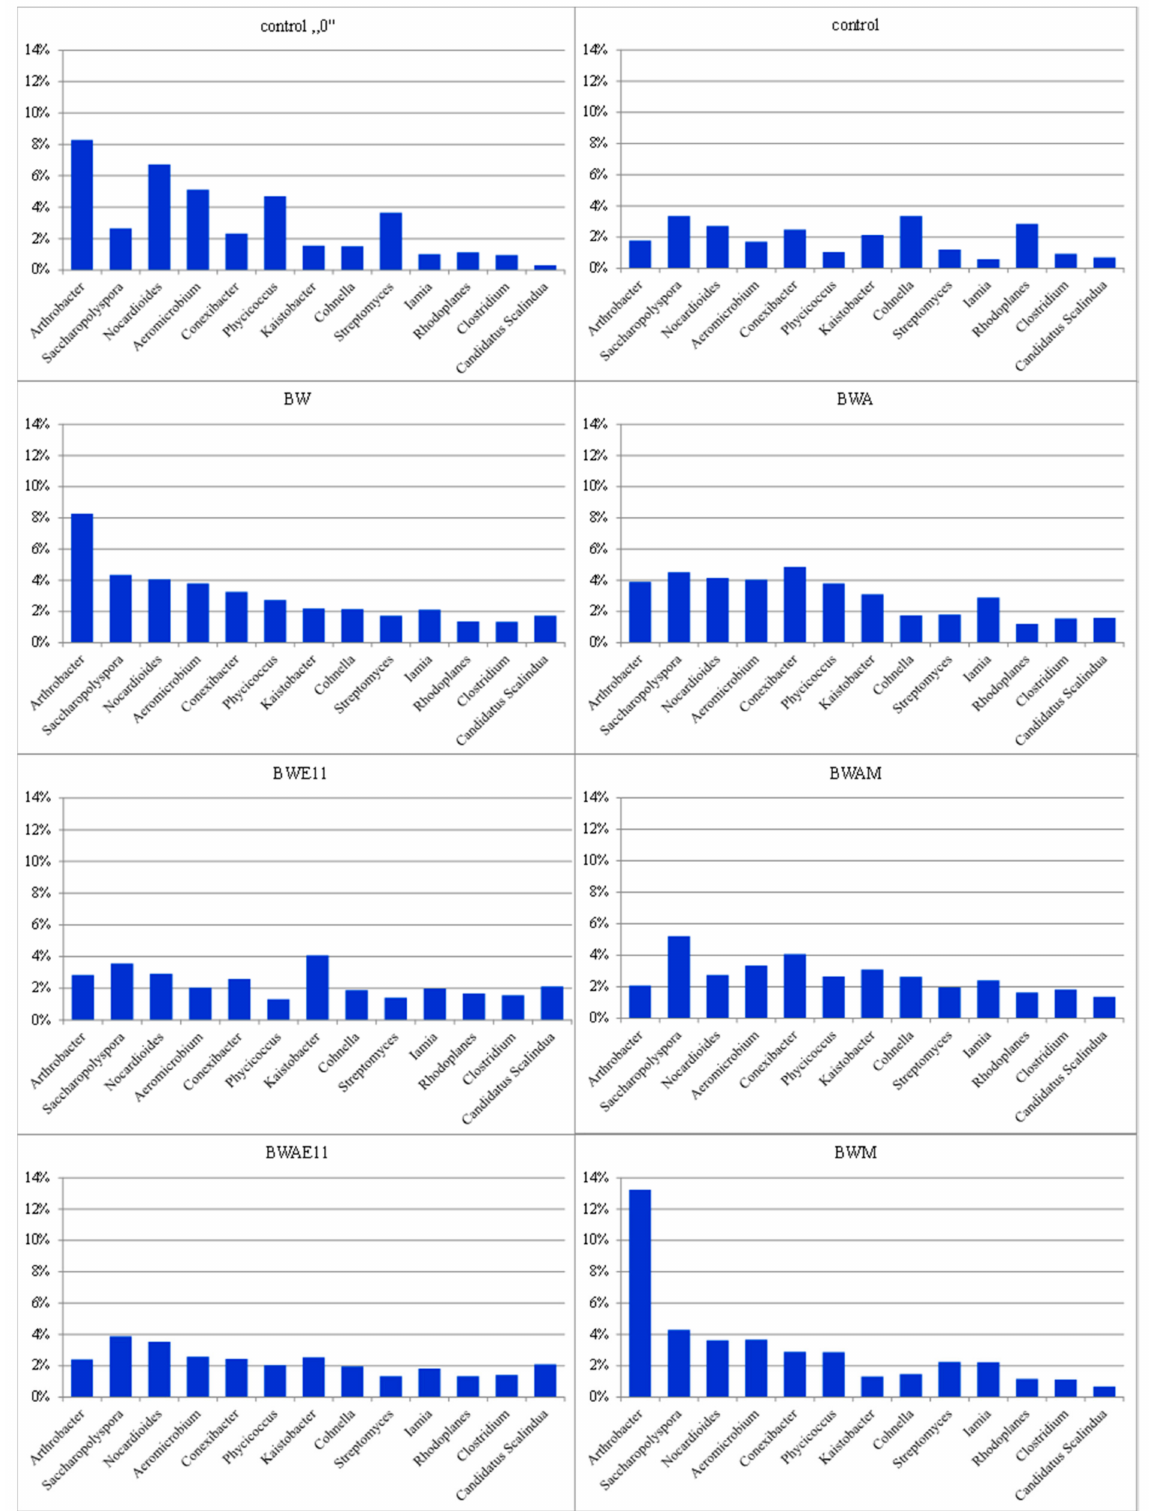
Figure 3. The percentage content of selected bacterial genus in the experimental variants. Explanation: control ‘0’—without fertilisers and plant cultivation, control—the control variant without fertilisers, with plant cultivation, BW—biochar fertiliser, BWM—biochar fertiliser with mycorrhizal fungi, BWE11—biochar fertiliser with Bacillus bacteria, BWA—biochar fertiliser with algae, BWAE11—biochar fertiliser with algae and Bacillus sp. bacteria, BWAM—biochar fertiliser with algae and mycorrhizal